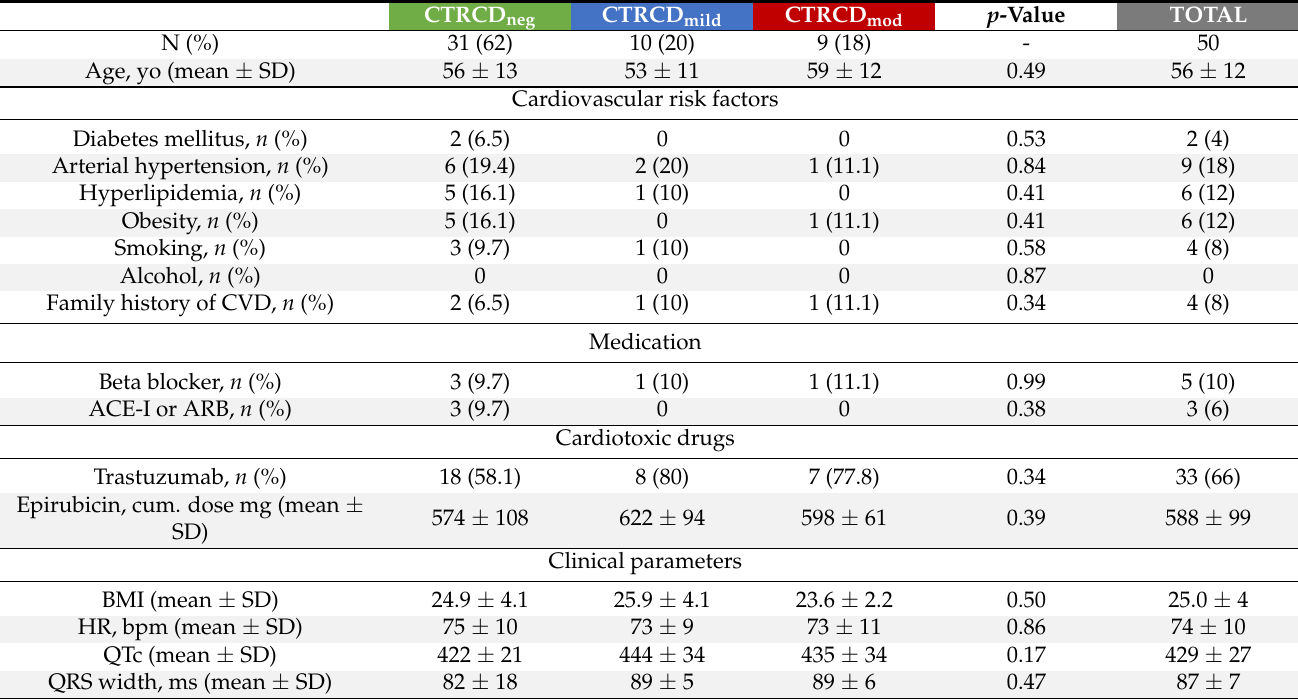
Table 1. Baseline patients’ characteristics and medical